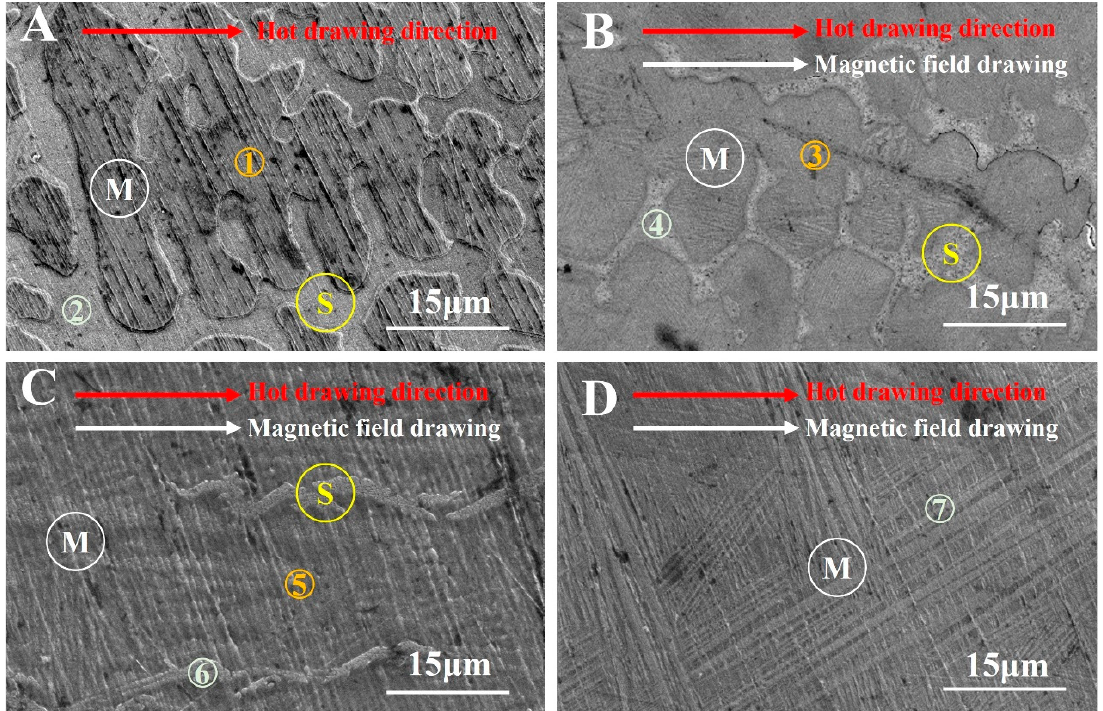
Figure 2. Microstructure characteristics of samples by SEM observation. ( A ) Sample a; ( B ) Sample b; ( C ) Sample c; ( D ) Sample d.